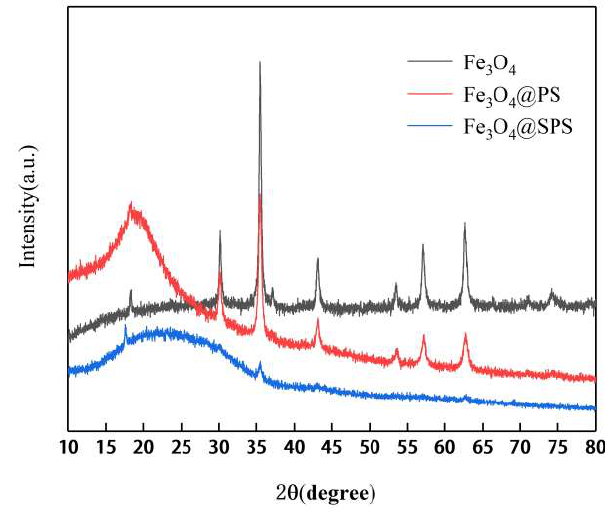
Figure 5. X-ray diffraction patterns of Fe 3 O 4 , Fe 3 O 4 @PS and Fe 3 O 4 @SPS.